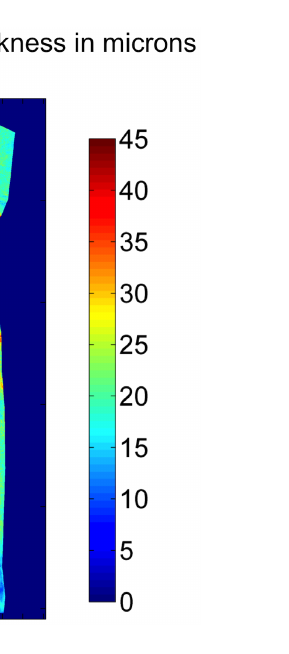
Fig. 3. Effect of the cuff on wall thickness. Thickness of the wall of a mouse carotid artery, obtained from en face stacks of confocal images, 1 week after a cuff was placed around the vessel in the conventional direction. The vessel was divided longitudinally; the image shows one half of it. Flow direction, cuff location and cuff orientation are indicated as described for Fig. 2. Compared to uncuffed regions, the wall was thickened near the throat of the cuff and where the wide end of the cuff lost contact with the vessel, and it was thinned within the cuffed